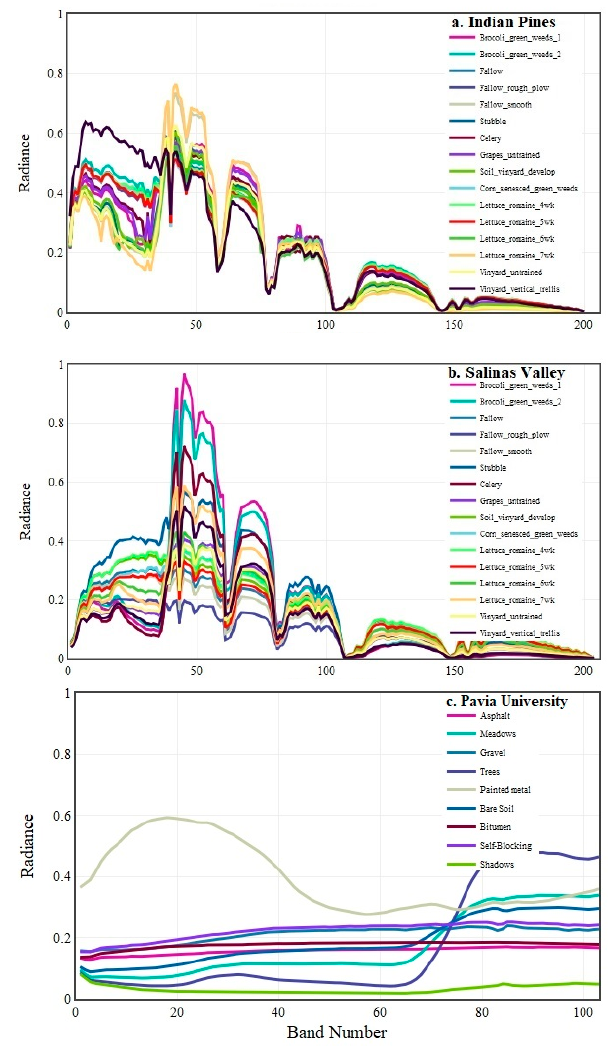
Figure 4. The mean spectral signatures of the ( a ) Indian Pines, ( b ) Salinas Valley and ( c ) Pavia University datasets.